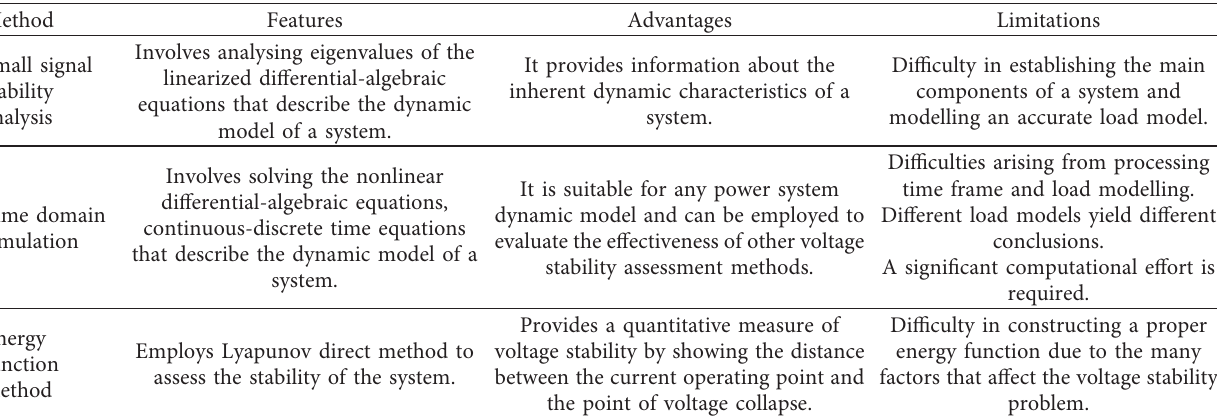
Table 2: Summary of popular dynamic voltage stability analysis methods.